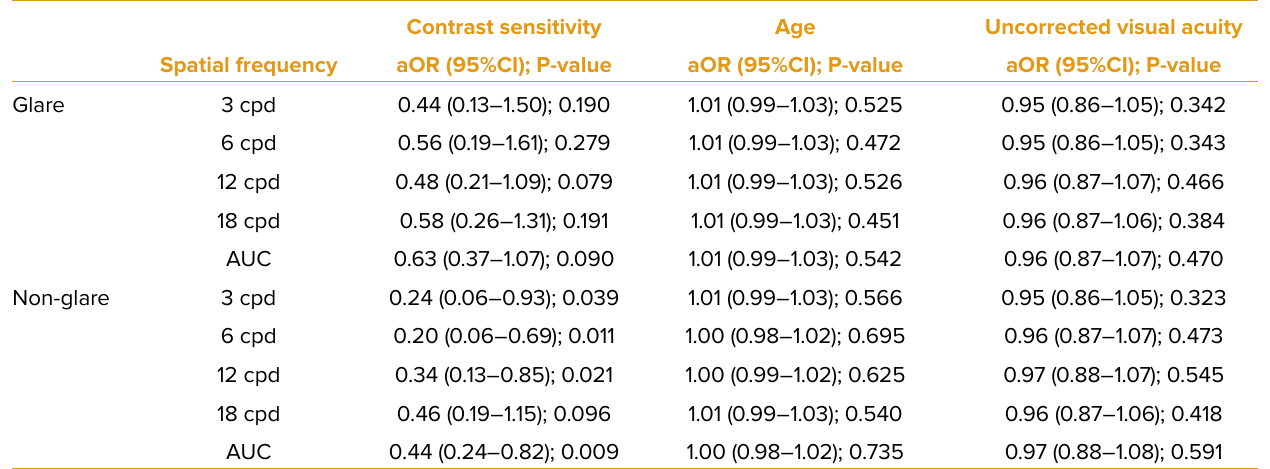
Table 2. The association between contrast sensitivity in different spatial frequencies under glare and non-glare conditions and being at fault for the accident after adjusting for the effect of age and visual acuity in a multivariable logistic regression